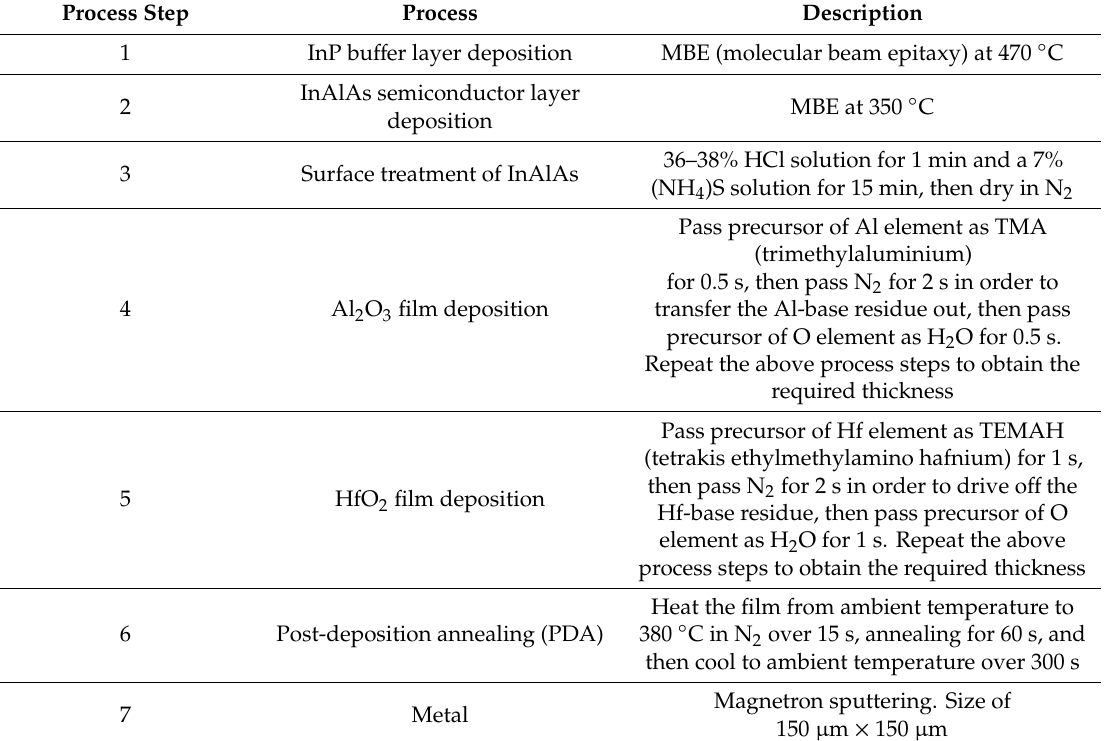
Process description of Au-Pt-Ti / HfO 2 -Al 2 O 3 / n-InAlAs metal-oxide-semiconductor (MOS)